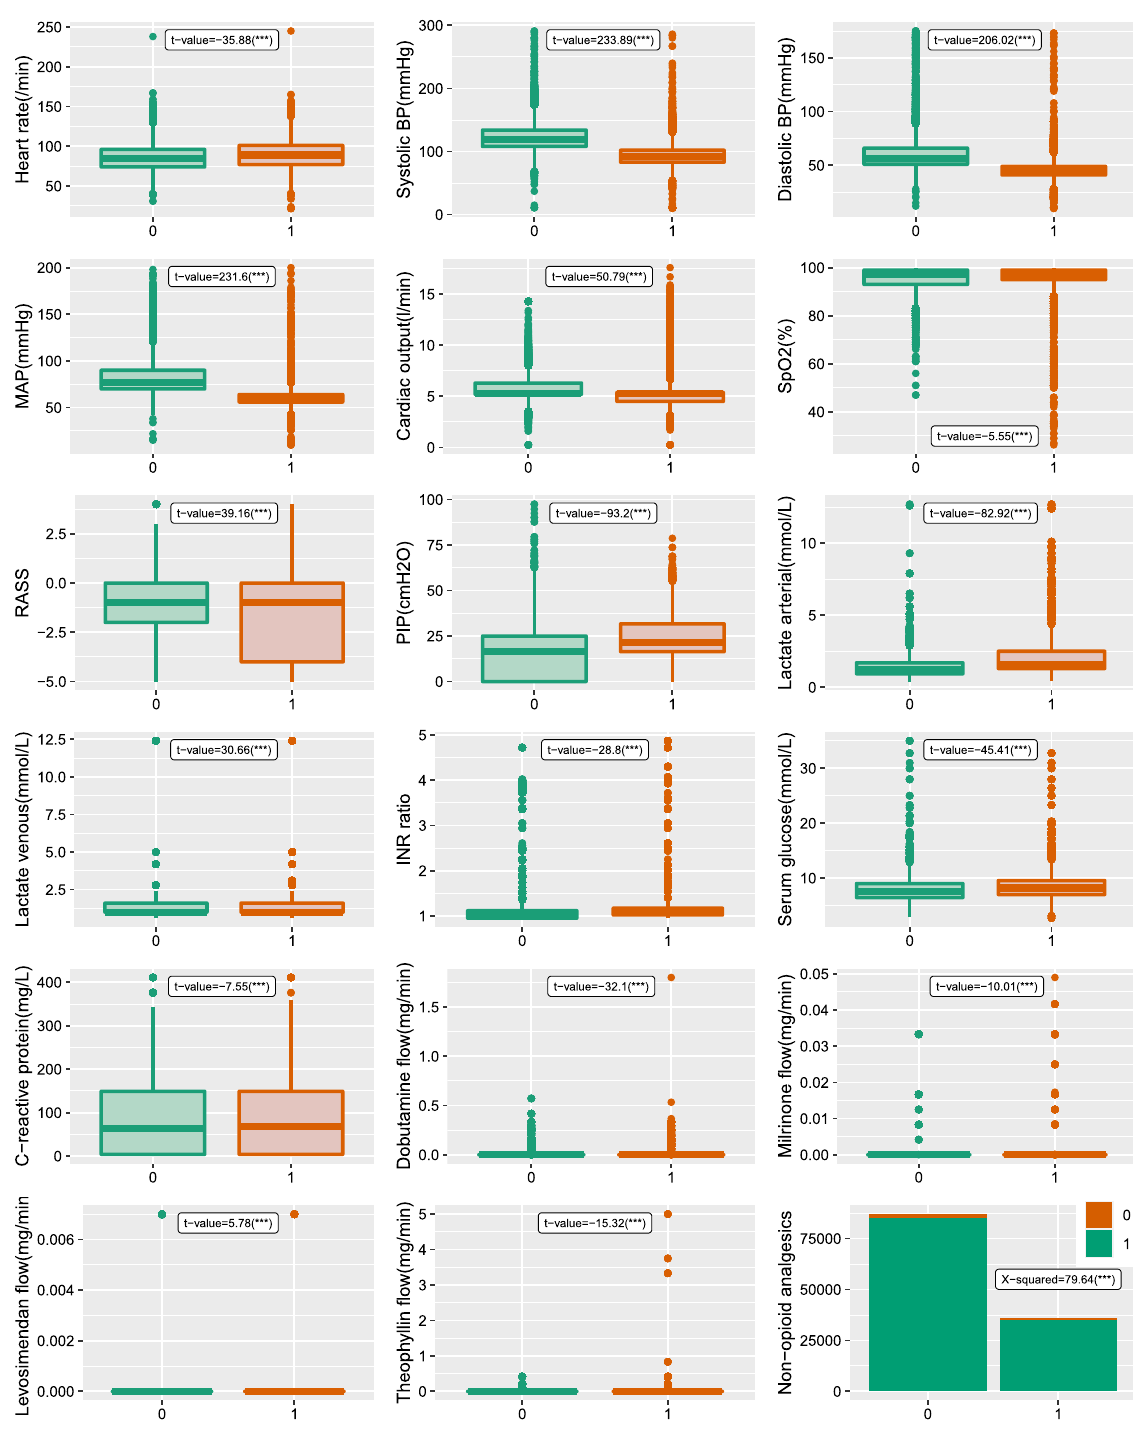
Figure 1. The variables information under state 0 and 1. The state 0 means the individual is not in circulatory failure and 1 means circulatory failure which should be alerted. The t value is based on the student t-test, and chi-squared test is conducted for the categorical variable Non-opioid analgesics, with all the p-value significant under level